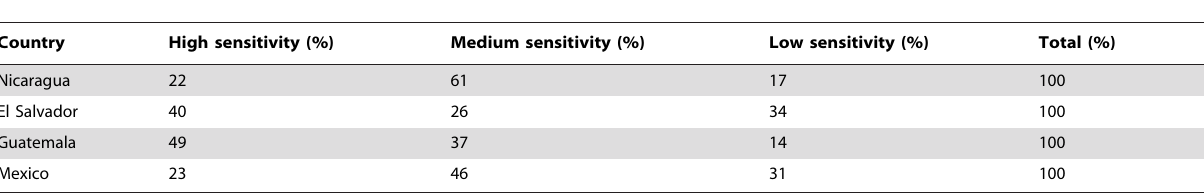
Table 3. Distribution of families per level sensitivity between countries.